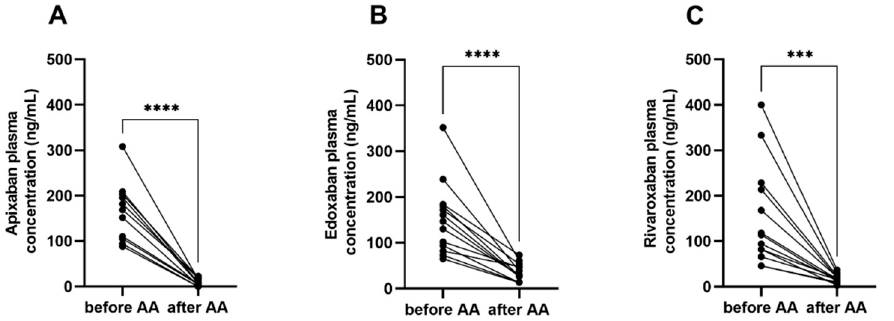
Figure 2. Factor Xa inhibitor. ( A ) Apixaban, ( B ) edoxaban, ( C ) rivaroxaban plasma concentration before and after spiking with the specific factor Xa-inhibitor Andexanet alfa. AA: Andexanet alfa; CT: Clotting time; RVV-test: Visco-elastic Russell’s viper venom assay. *** p < 0.001; **** p < 0.0001, paired t -test.